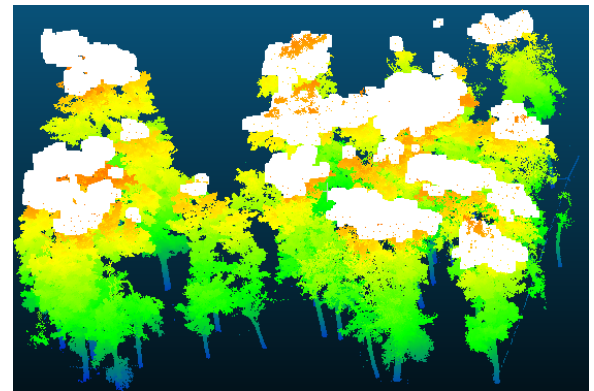
Figure 13.The extraction of non-ground seed points superimposed on source data(cloth resolution is